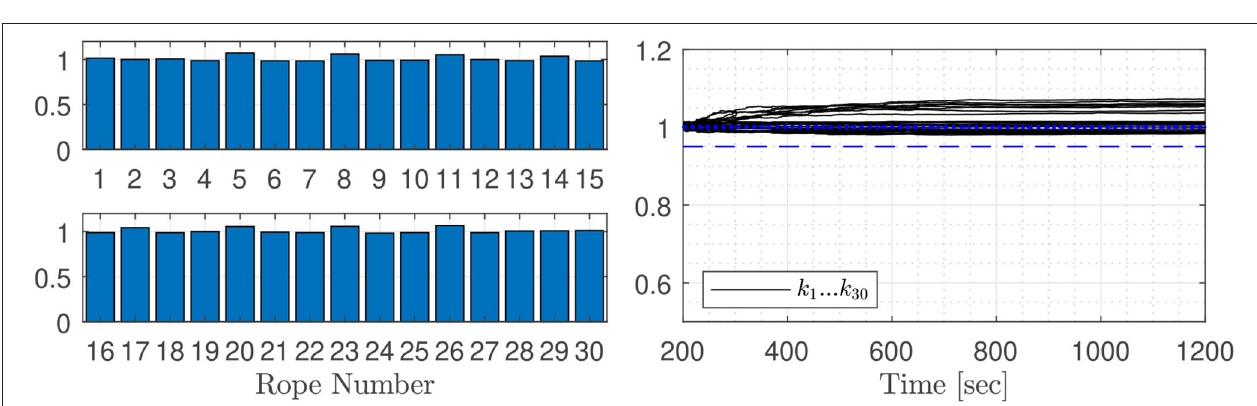
FIGURE 6 | Normalized estimated rope stiffness test case I, fault free